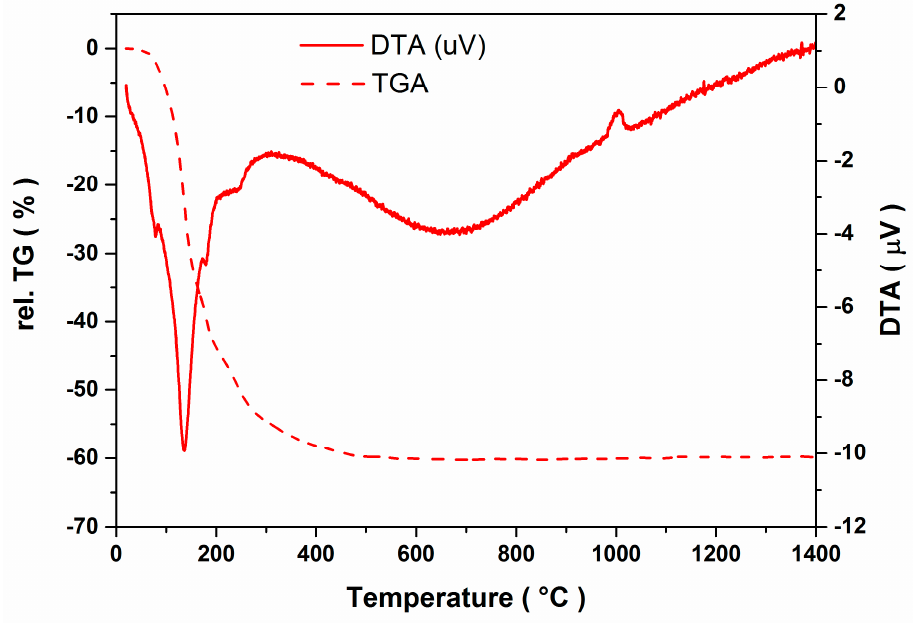
Figure 1. DTA and TG curve of gel dried at 85 °C, 12 h.